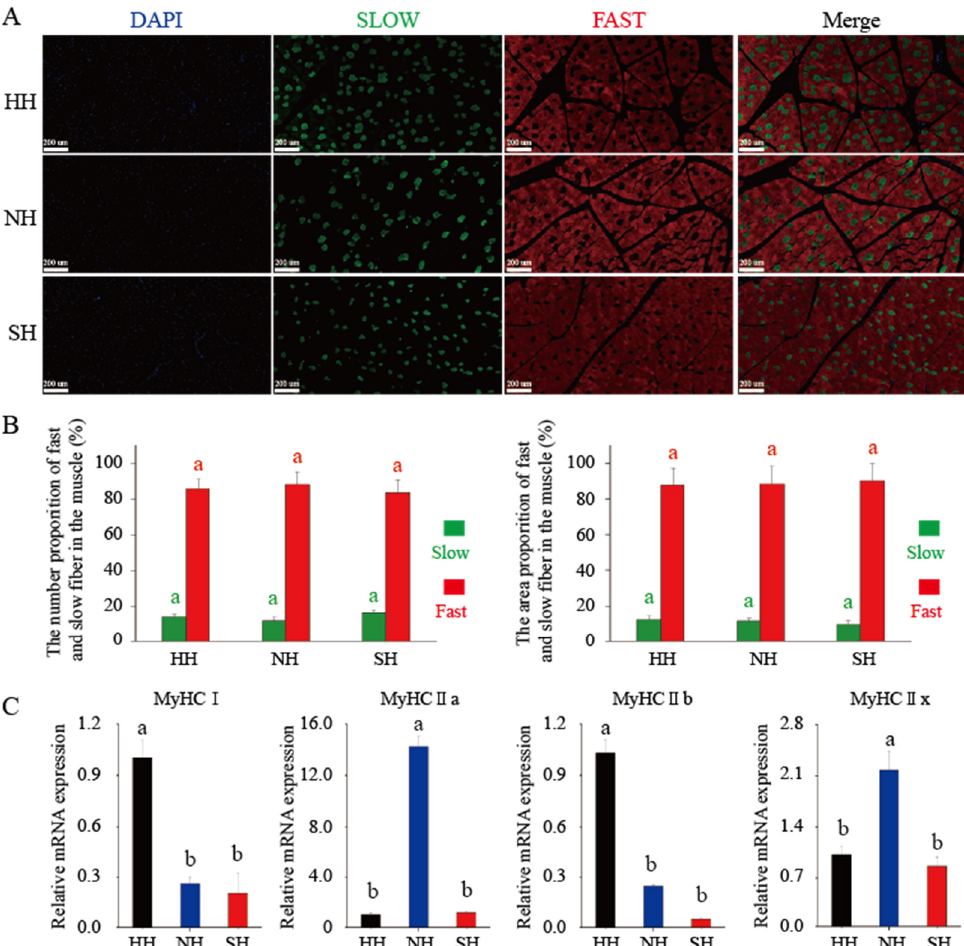
Figure 3. Muscle fiber type composition in F 1 crossbred lambs. ( A ) Immunofluorescence staining detected the distributions of fast and slow muscle fibers. ( B ) The number and area proportion of fast and slow fiber in the muscle. ( C ) Expression of MyHCs genes in F 1 crossbred lambs. Scale bars, 100 µm. All data were expressed as mean ± SD ( n = 3). Different letters indicate significant differences at p < 0.05. HH: Hu × Hu, NH: Southdown × Hu, SH: Suffolk × Hu.